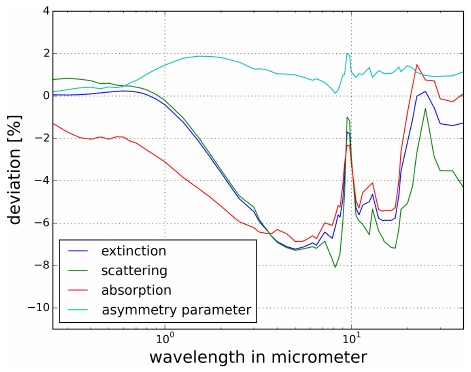
Figure 6. Deviation (%), between spherical and non-spherical “desert” aerosol for different optical